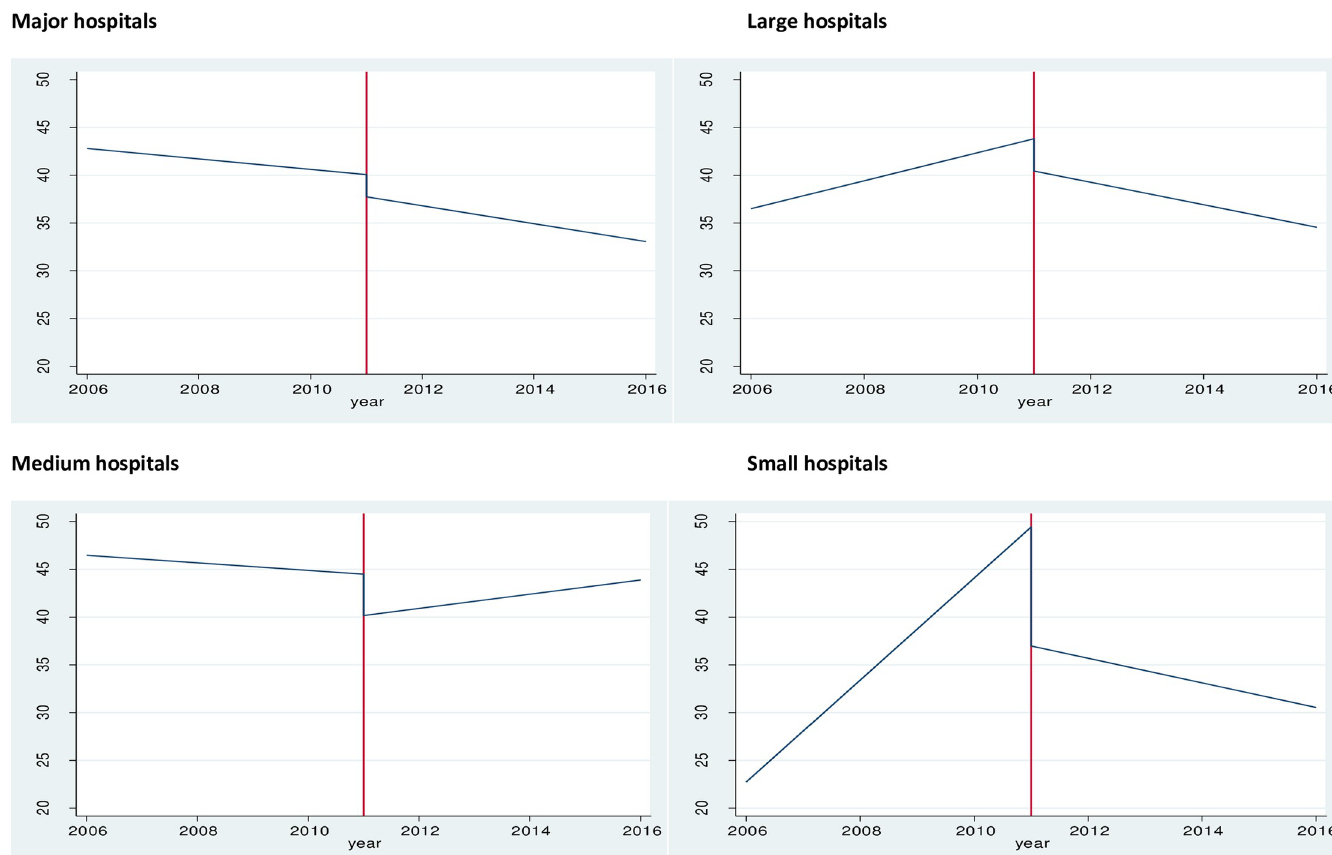
Fig 1. Mean time to treatment (minutes) by year of presentation and hospital peer